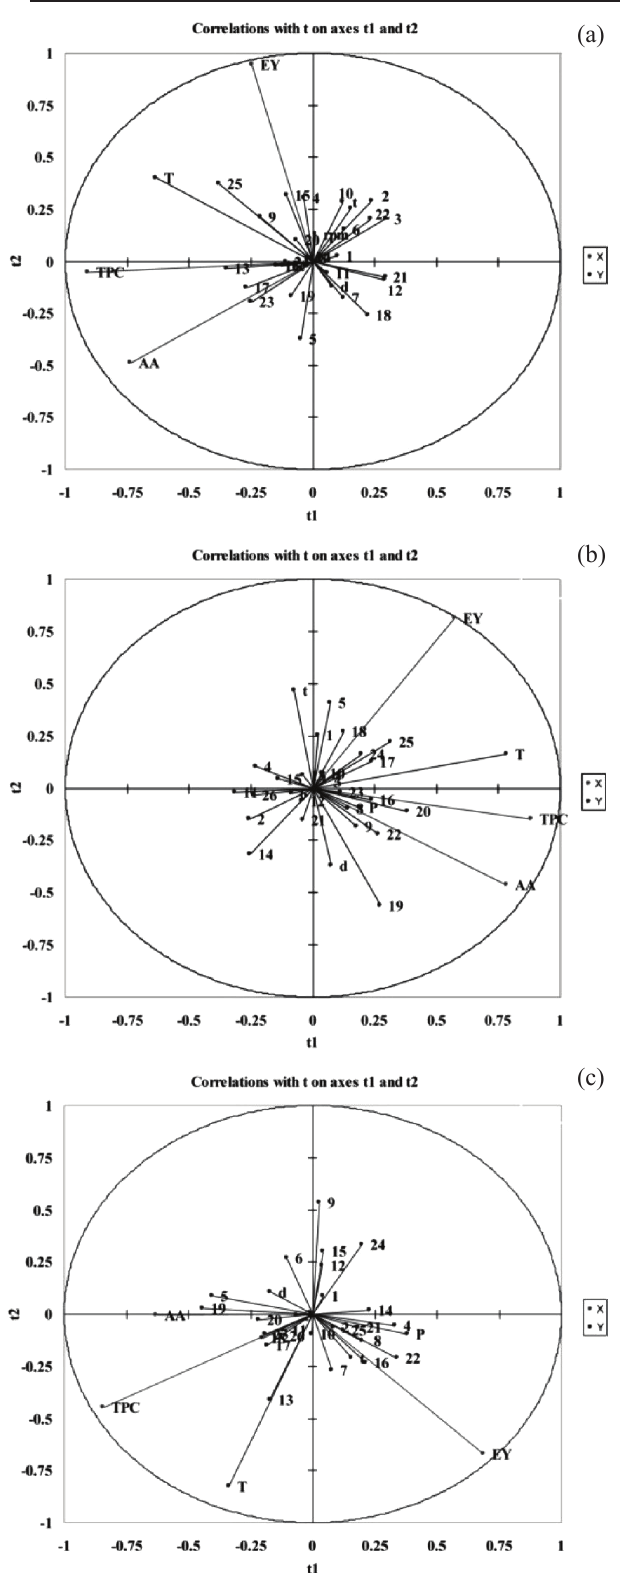
Fig. 2 – Geometrical representation of PLS models for deter- mination of correlations between PCA factors combined with extraction process parameters (temperature, time, particle di- ameter, and rpm) and total polyphenols concentration, antioxi- dant activity, and extraction yield for a) classical extraction, b) microwave-assisted extraction, and c) microwave-ultrasound- assisted